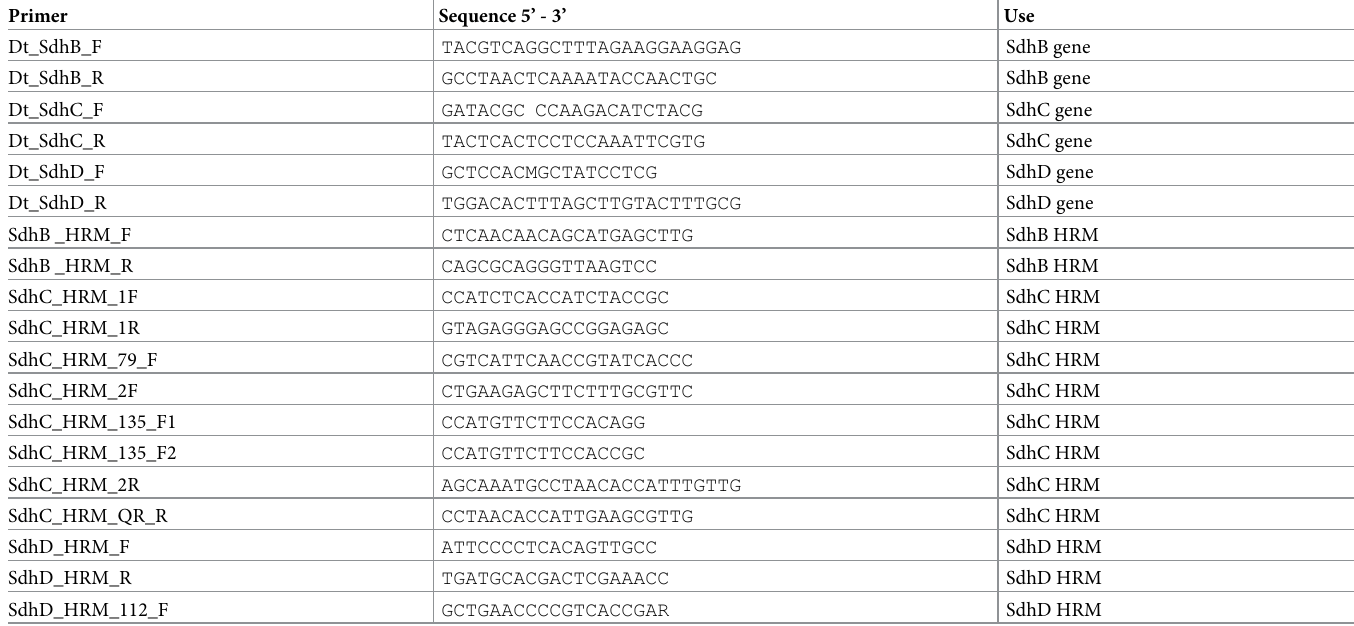
Table 4. Primers used for amplification of Sdh B, Sdh C and Sdh D genes and High-Resolution Melt (HRM) assay.